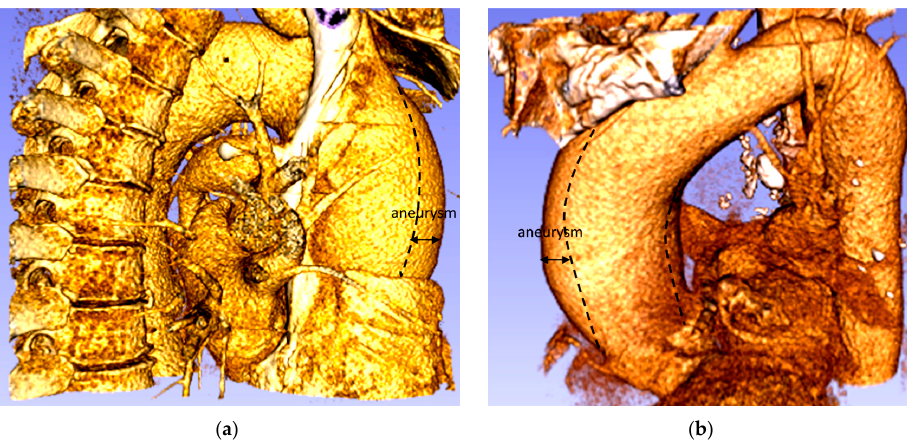
Figure 2. Aneurysm of the ascending thoracic aorta: ( a ) Patient 1; ( b ) Patient 2.